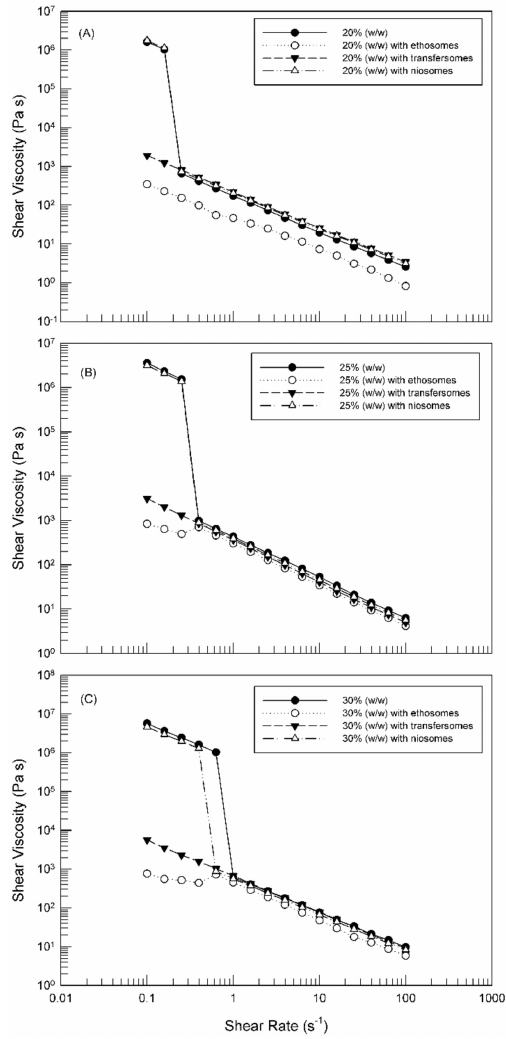
Figure 7. Flow curves (shear viscosity versus shear rate) of ( A ) 20% Poloxamer 407, ( B ) 25% Poloxamer 407 and ( C ) 30% Poloxamer 407, with and without carriers. The illustrated results were representative of three independent